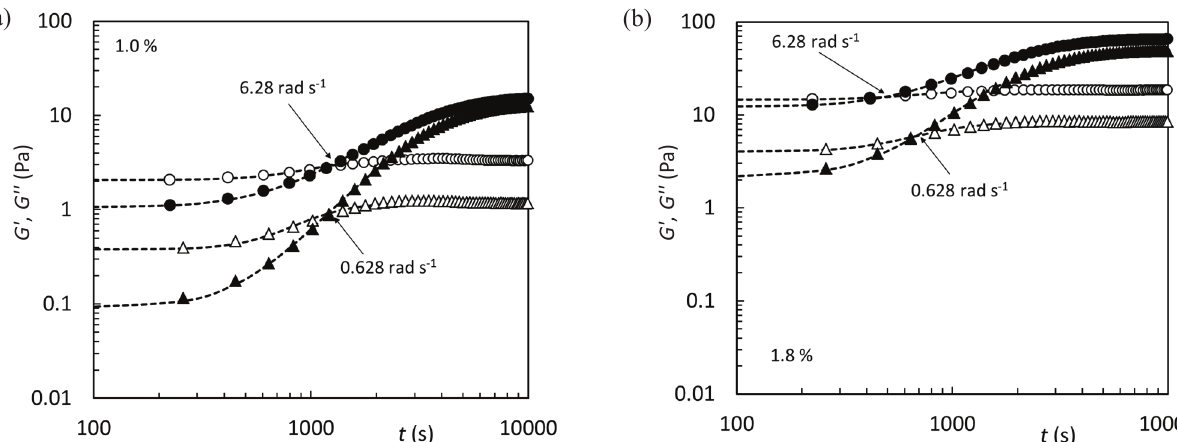
Fig. 1 – Time evolution of the viscoelastic moduli of systems 1.0 %wt (a) and 1.8 %wt (b) at two frequencies. Symbols: w = 0.628 rad s –1 (triangles), w = 6.28 rad s –1 (circles); black (G'), white (G''). Lines in the figures represent the best fits of the experimental data obtained with Eq. (3).